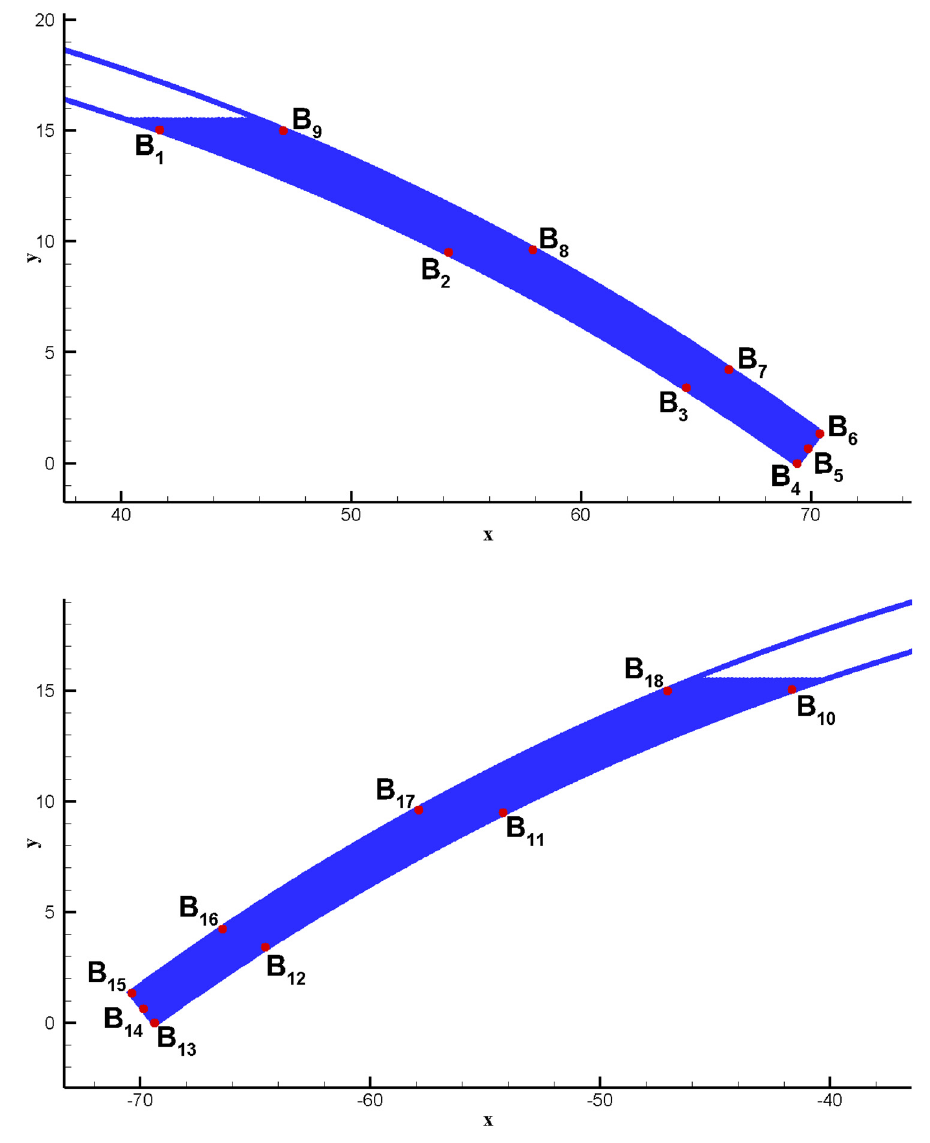
Figure 6. Position of boundary particles for monitoring.